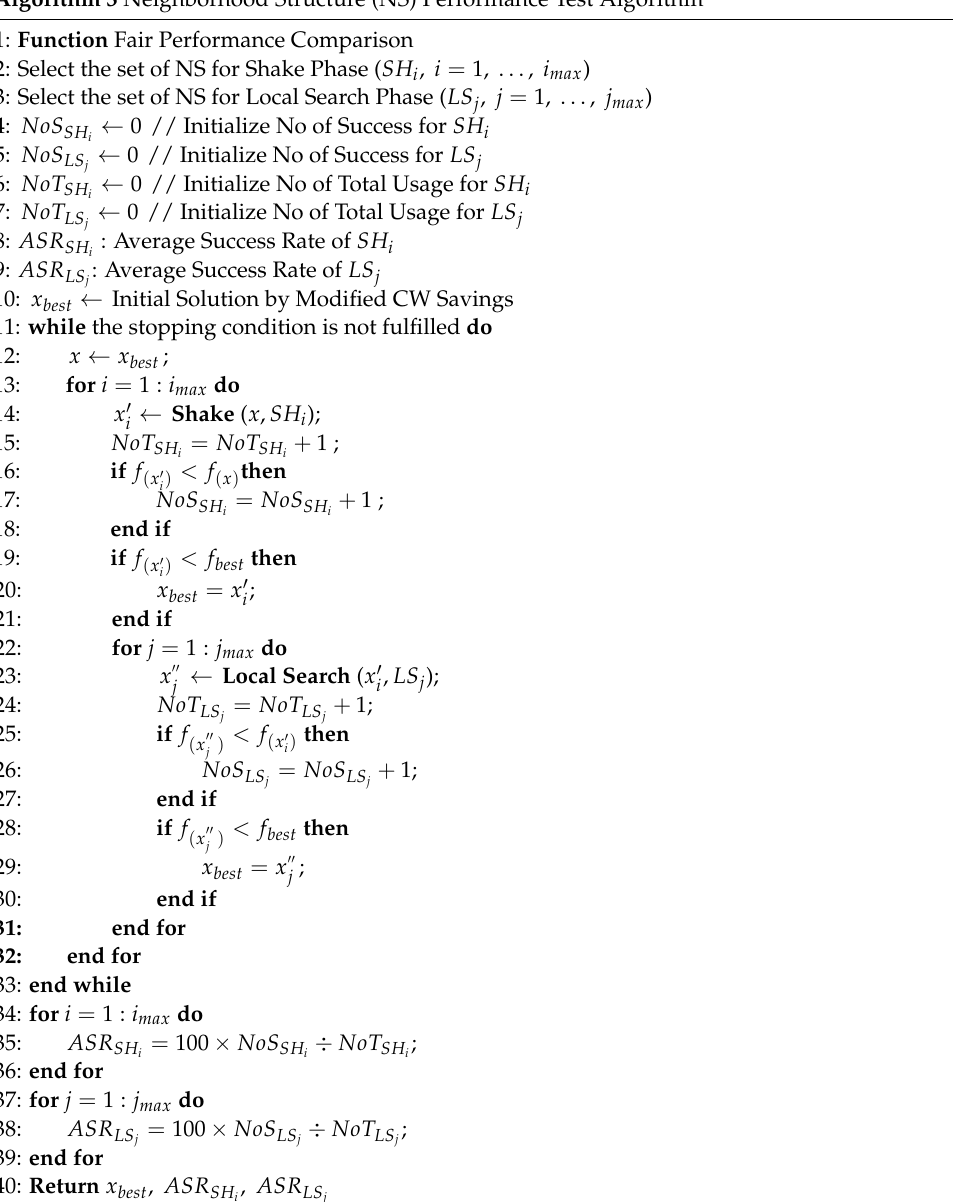
Algorithm 3 Neighborhood Structure (NS) Performance Test